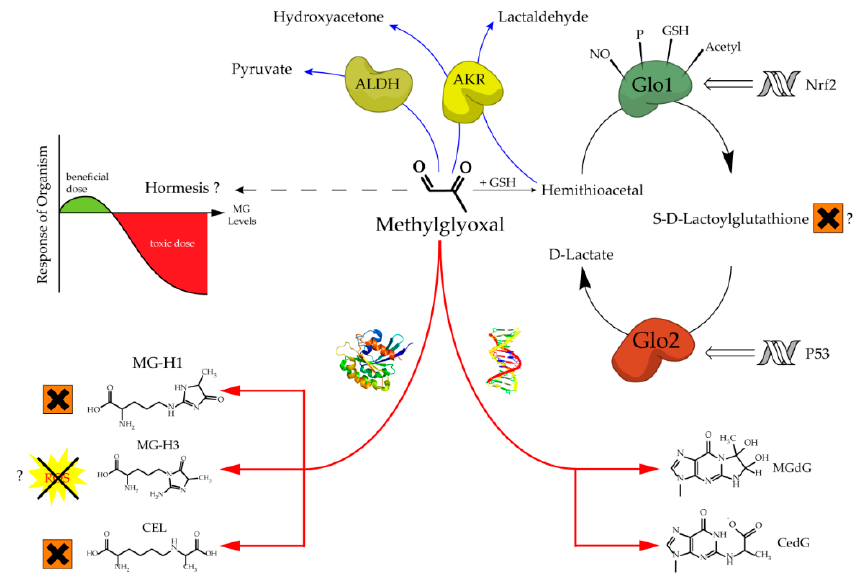
Antioxidants 2020 , 9 , x FOR PEER REVIEW Figure 1. Aspects of methylglyoxal metabolism and its possible implications. Figure 1. Aspects of methylglyoxal metabolism and its possible implications.